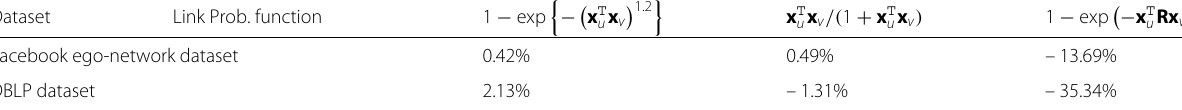
Table 4 Relative improvement of the community detection accuracy with different link probability functions H ( x u , x v ) Dataset